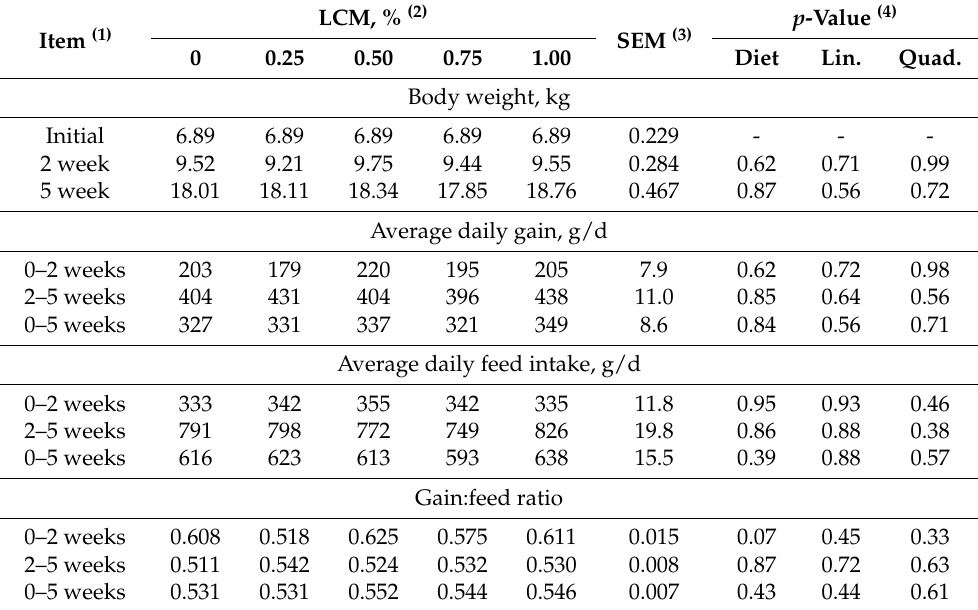
Table 6. Effects of LCM supplementation levels on growth performance in weaning pigs (exp. 1).